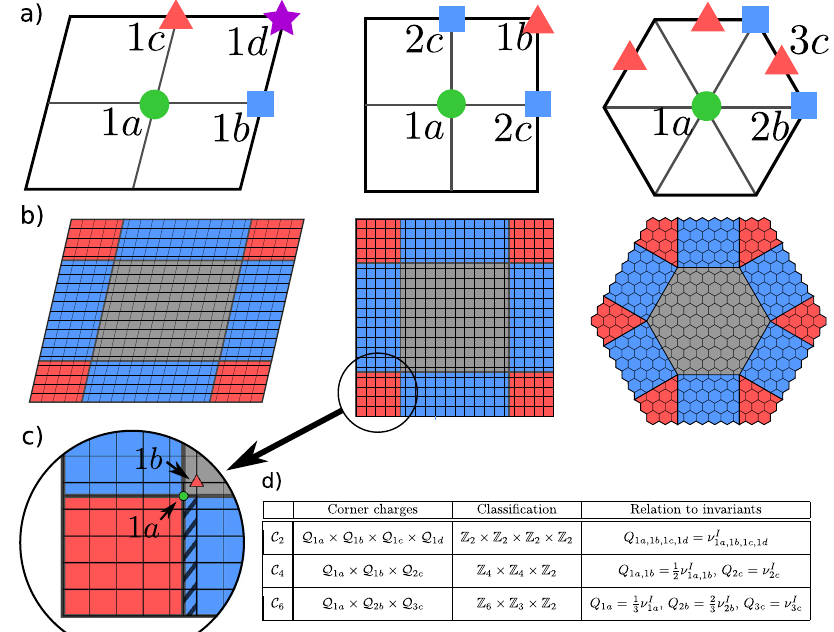
Fig. 1 Bulk and corners of two-dimensional rotation-symmetric crystals. a Unit cells of rotation-symmetric crystals. The special Wyckoff positions and their multiplicities are explicitly indicated. b Rotation-symmetric crystals in open-disk geometries. The red, blue, and gray regions indicates bulk, edges, and corners, respectively. Note that when considering a reference C 2 -symmetric Wyckoff position, the corner charge has to be summed over the adjacent corners not related by C 2 symmetry in order to represent a quantized bulk quantity. c Zoom in of the C 4 -symmetric corners with the two possible reference Wyckoff positions. d Table of the corner charge topological characterization for ; C C C 2 4 , and 6 symmetric